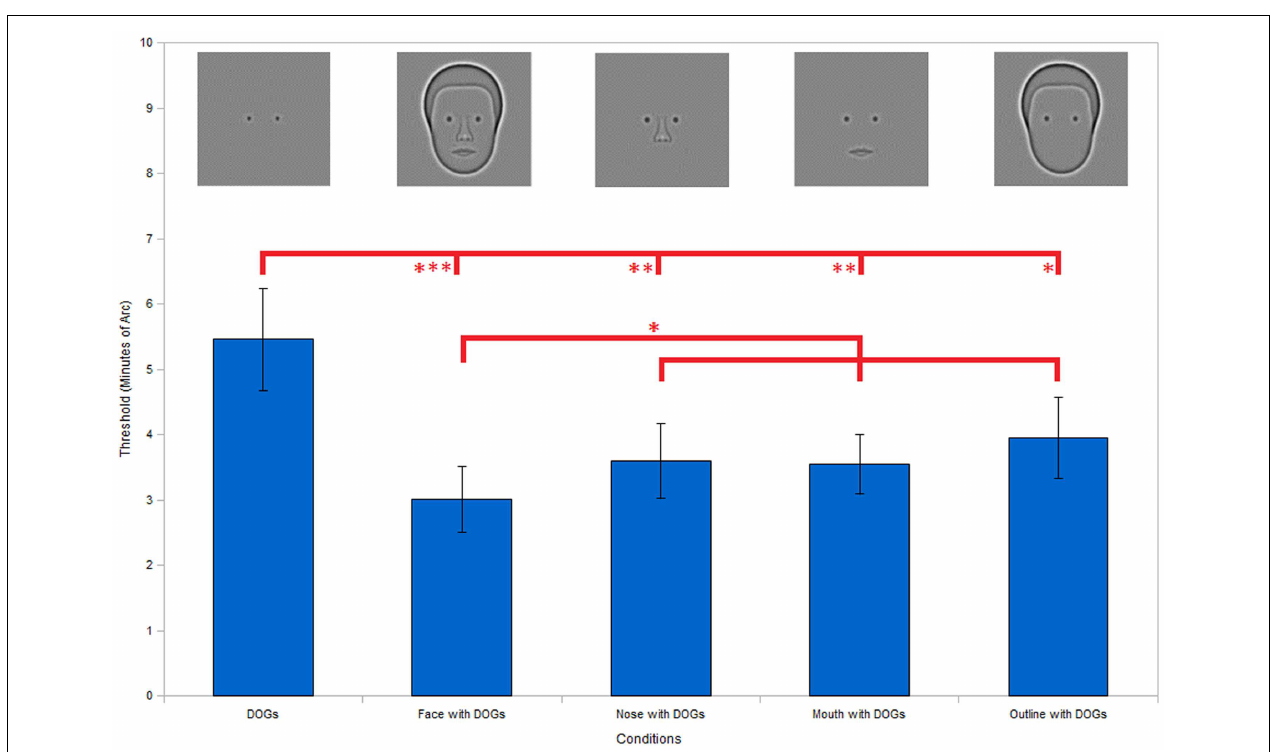
three single feature conditions show significant differences from the face condition individually. However, collecting the data from all three condition into a single set shows a significantly higher threshold than the face condition. Error bars represent standard error. (*** P < 0.001; ** P < 0.01; * P <